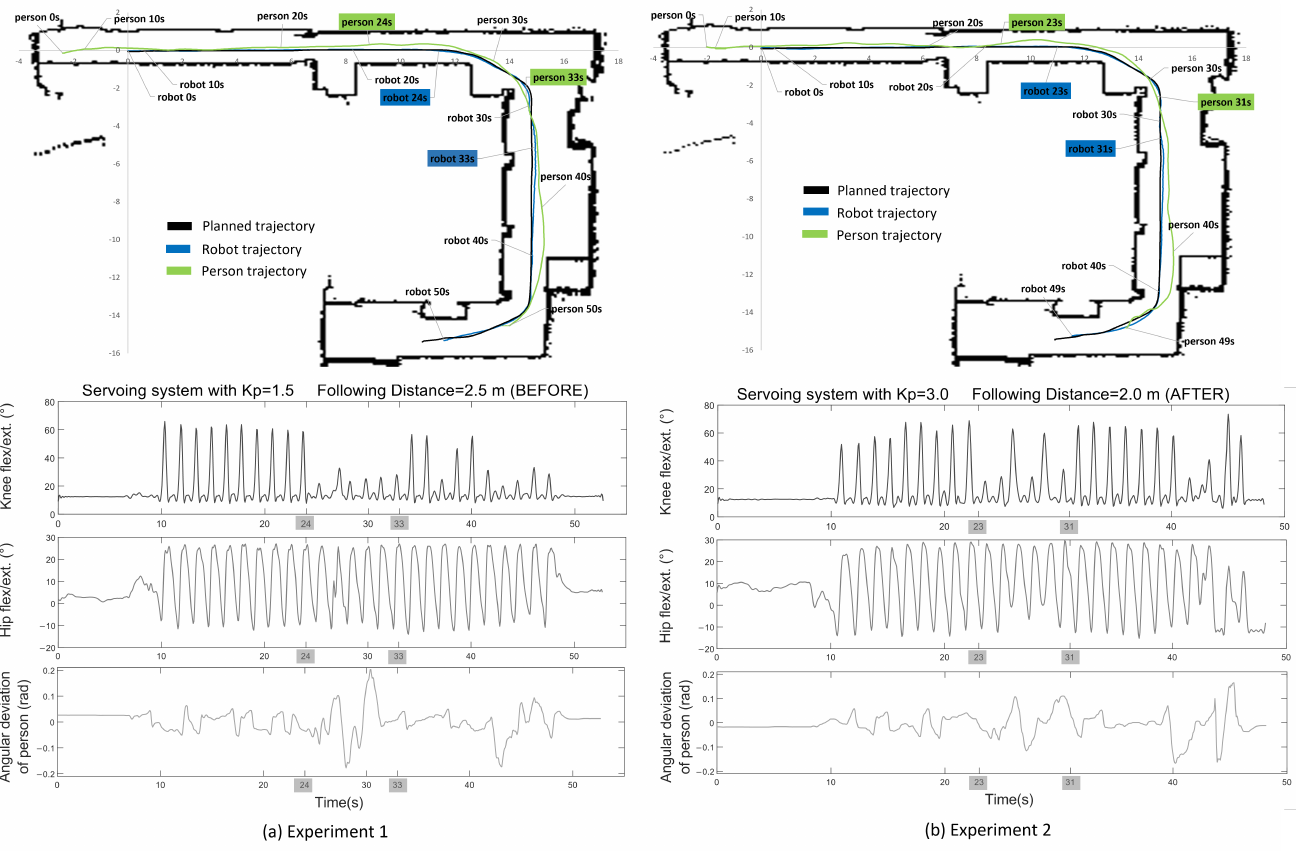
Figure 10. Experiment 1. Servoing system gain of Kp = 1.5 and following distance of 2.5 m. Experiment 2. Servoing system gain of Kp = 3.0 and following distance of 2.0 m. The maps show the planned path and the real path followed by the robot and the person. The kinematic joint signals (knee and hip flex./ext. in the entire experiment) in addition to the angular position of the person in the camera coordinate